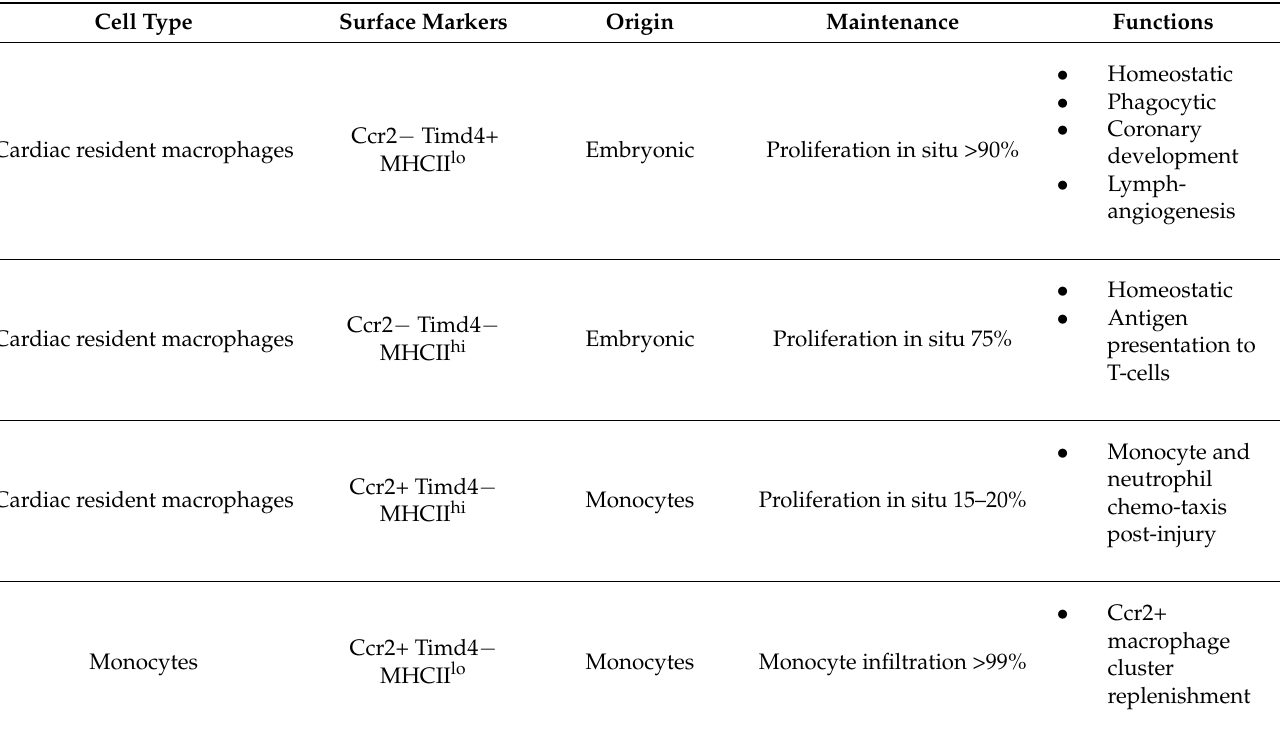
Table 1. Cardiac-resident macrophage clusters by surface protein, origin, maintenance, and